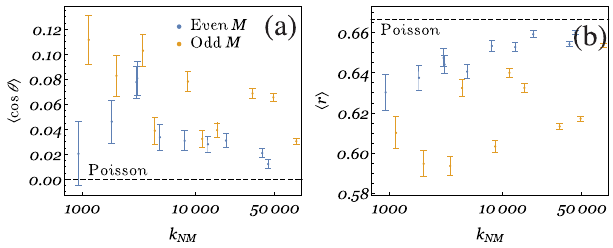
FIG. 7. Finite-size effects on the complex spacing ratios of a spin-chain Liouvillian of the dephasing- XX model, for different chain lengths N and spin sectors M , the sector dimension being 2 N k Þ . (a) Average value of cos θ ; (b) average value of r . NM ¼ ð M The upper (lower) dashed line corresponds to the GinUE (Poisson) limit.